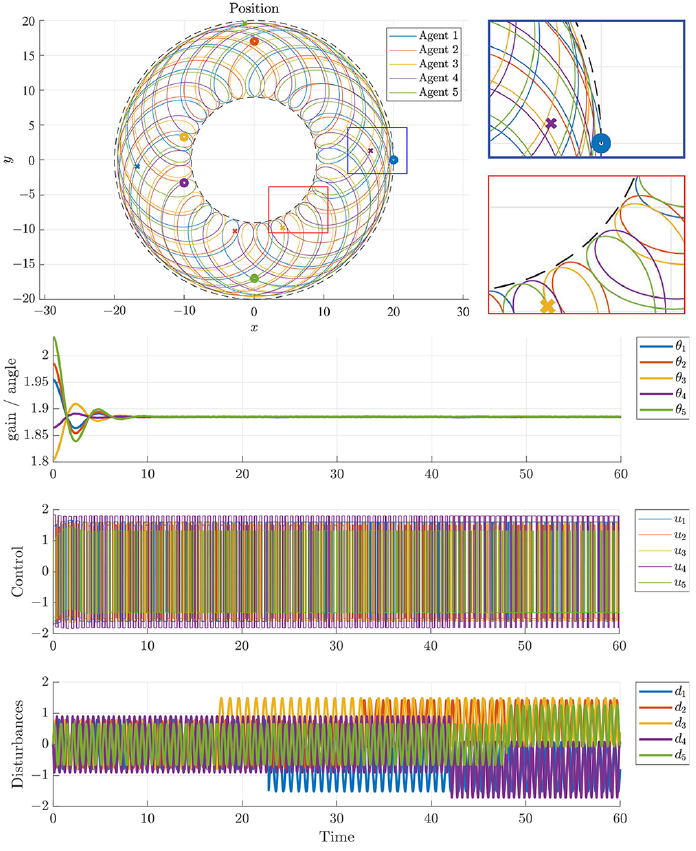
Figure 3. Pattern and angle variations, control, and disturbances under (13).